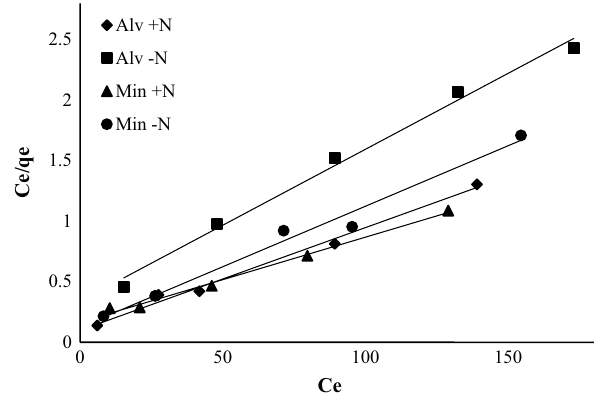
Fig. 9 Langmuir isotherm for copper ions onto N. alveolaris + N, N. alveolaris